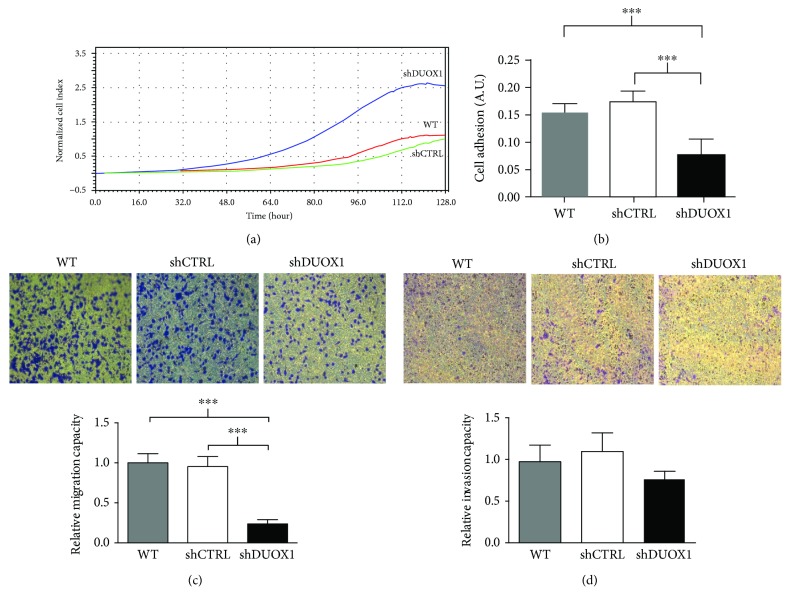
DUOX1 silencing increases proliferation and decreases adhesion and migration in nontumor MCF12A cells. Cellular proliferation (a) and adhesion (b) were evaluated by the xCELLigence system in DUOX1-deficient (shDUOX1) and control (shCTRL) cells. For migration (c) and invasion (d), the cells were allowed to migrate through uncoated transwells for 8 h or invade through Matrigel-coated transwells for 24 h. The number of cells at the bottom of the transwell filters was counted at the end of each assay. Results are presented as means ± standard errors from three independent experiments. ∗∗∗P < 0.001.